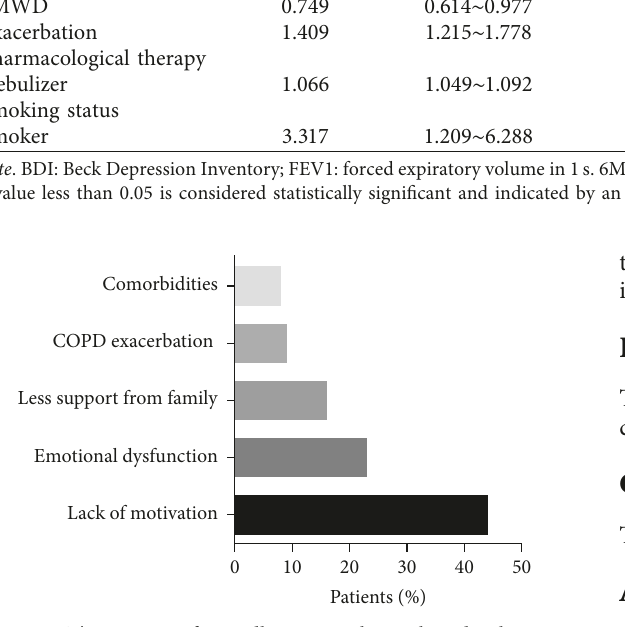
Figure 2: The reasons of nonadherence in home-based pulmonary